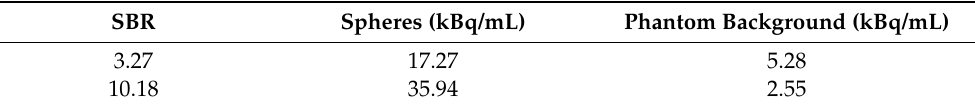
Table 1. This table reports the two final signal-to-background with the respective concentrations in spheres and in